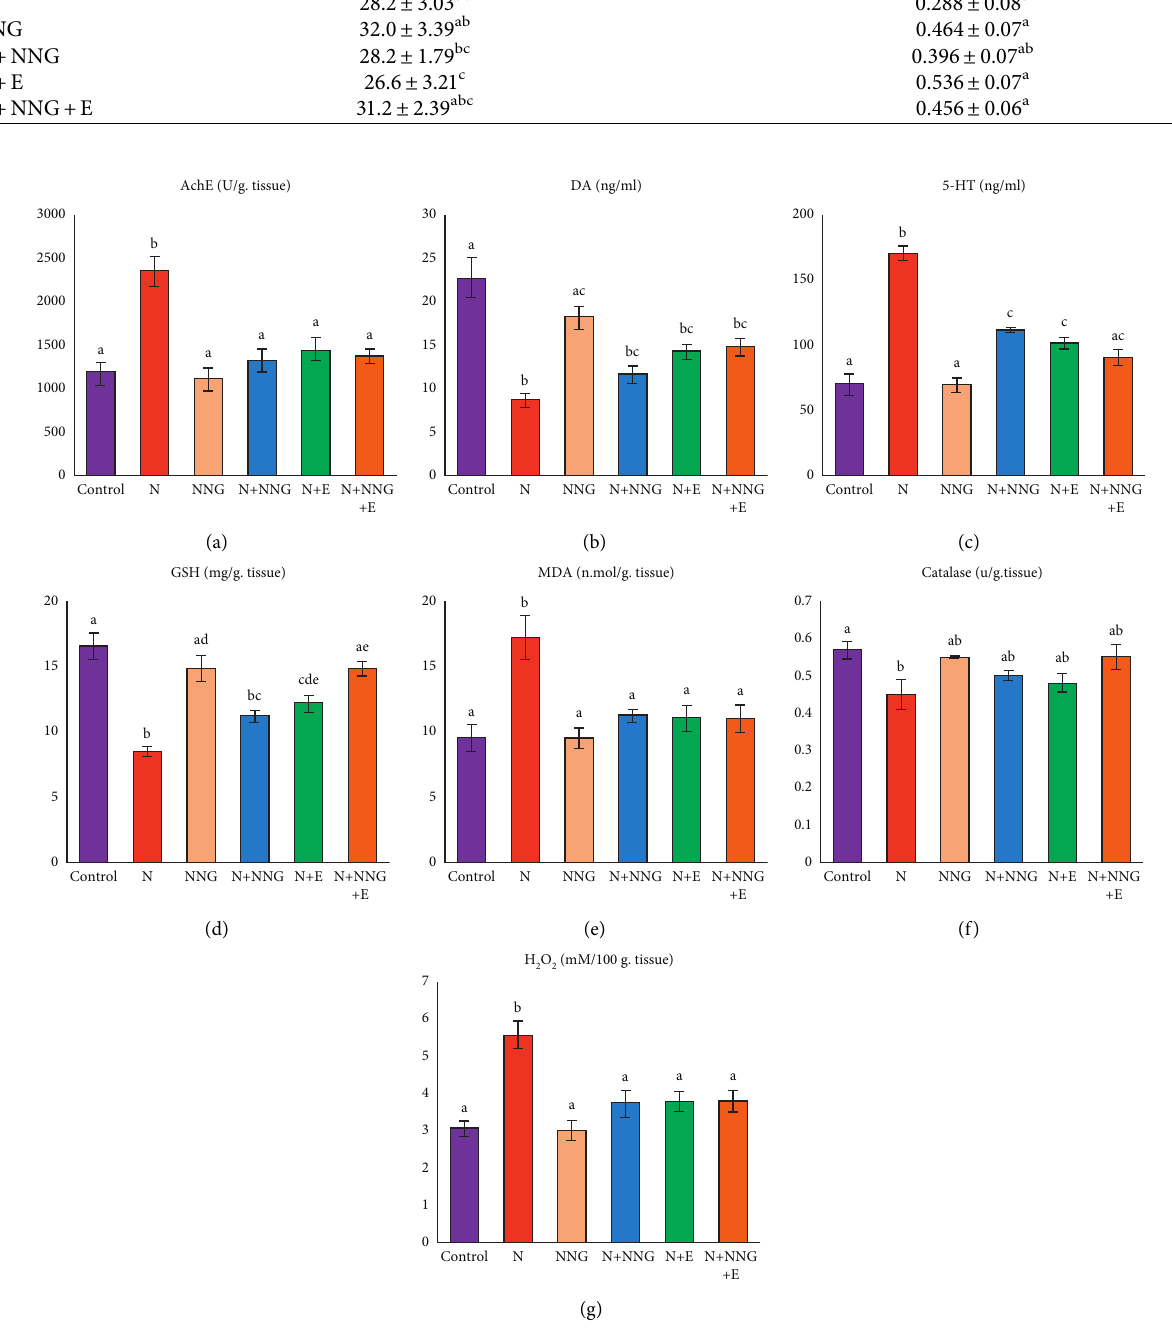
Figure 2: Effect of different treatments on (a) acetylcholinesterase activity, (b) dopamine (DA), (c) serotonin (5-HT), (d) GSH, (e) MDA, (f) catalase, and (g) H 2 O 2 concentrations in the brain tissue of rats in different groups. Results are expressed as means ± SE ( n � 10). Values with different letters in a column are significantly different at level p < 0 . 05. N: nicotine, NNG: nanonaringenin, E: vitamin E, DA: dopamine, 5-HT: serotonin, GSH: reduced glutathione, MDA: malondialdehyde, H 2 O 2 : hydrogen